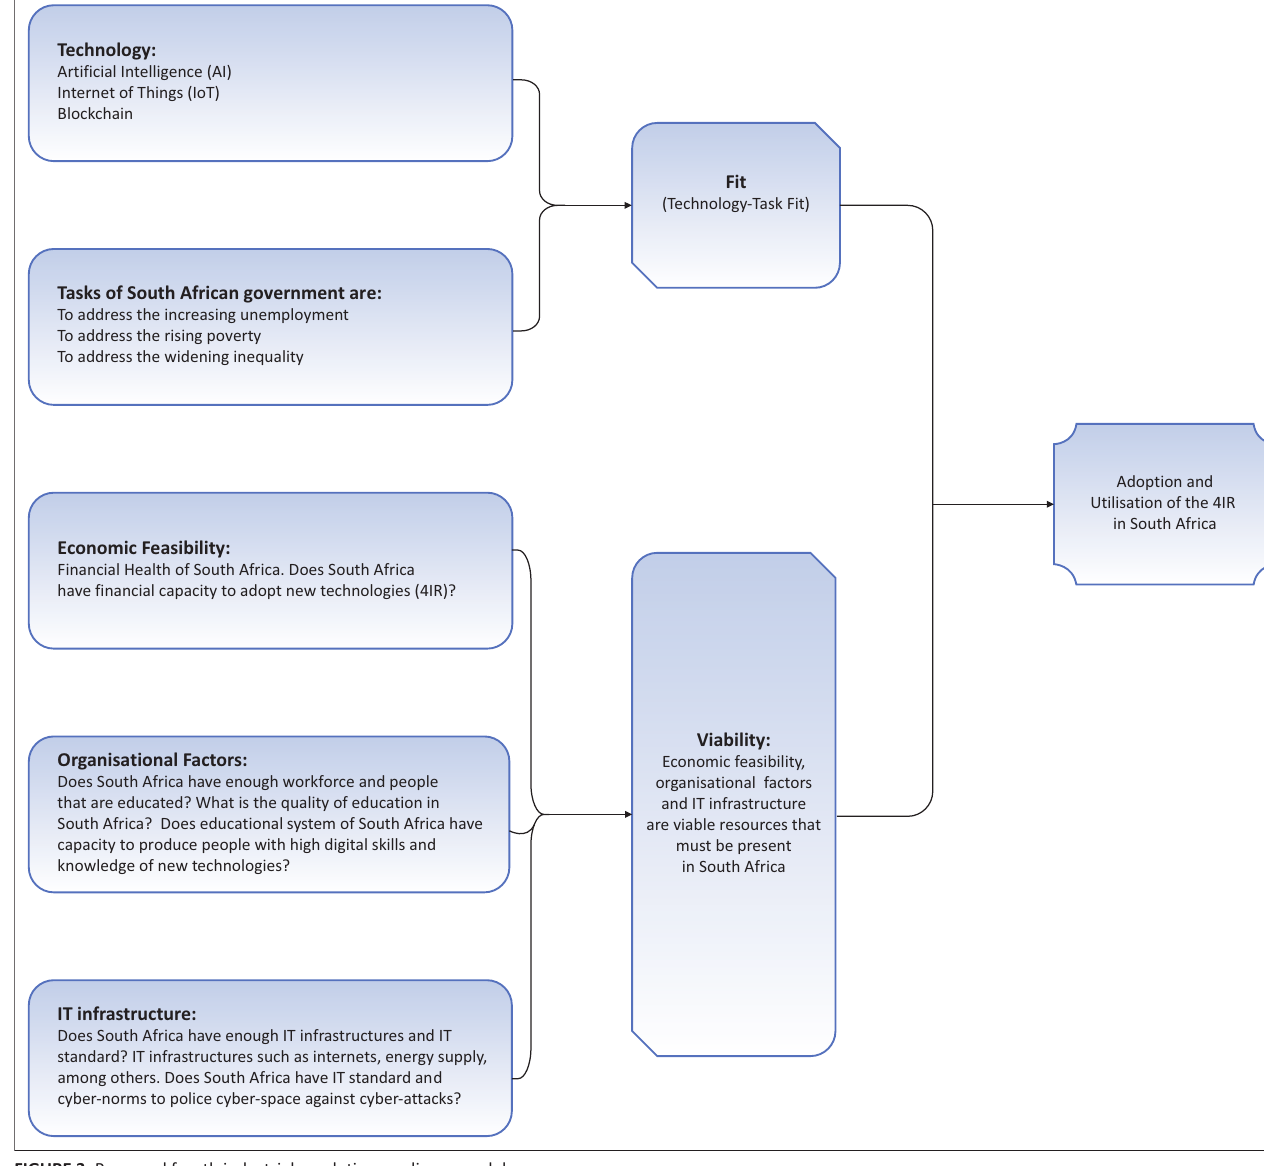
FIGURE 3: Proposed fourth industrial revolution readiness